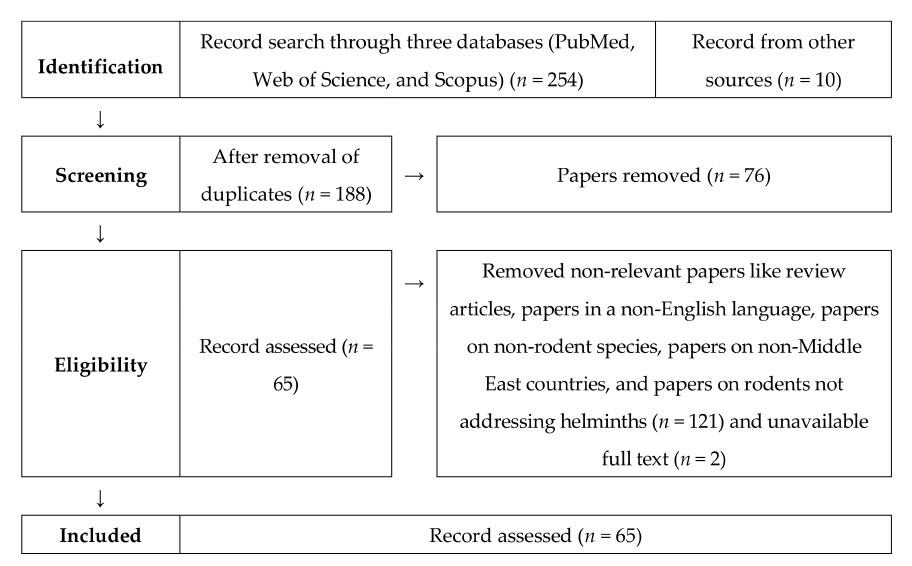
Figure 1. Systematic review PRISMA flow diagram describing the selection of published articles on rodent helminths in the Middle East and inclusion / exclusion process used in the